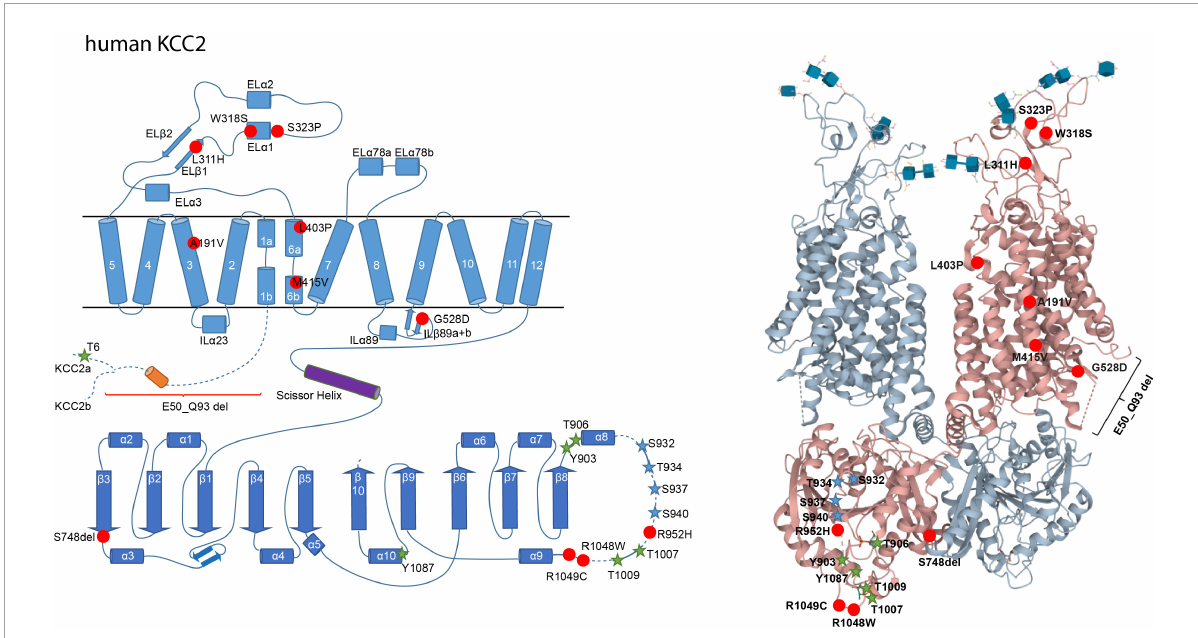
FIGURE2 Structural organization of human KCC2. 2-dimensional (left) and 3-dimensional (right) organization of human KCC2 according to Chi X. et al. (2020) (PDB: 6m23). KCC2 consists of 12 transmembrane domains (TMs) and two intracellular termini. A large extracellular loop is located between transmembrane domains 5 and 6 (EL3) and five N-glycosylation sites (blue cubes, left). Phosphorylation sites that increase KCC2 activity upon dephosphorylation are marked as green stars (Thr 6 in KCC2a, Thr 906 , Tyr 903 , Thr 1007 , Thr 1009 , and Tyr 1087 ). Phosphorylation sites that increase KCC2 activity upon phosphorylation are marked as blue stars (Ser 932 , Thr 934 , Ser 937 , Ser 940 ). Human pathogenic variants of KCC2 associated with epilepsy, autism-spectrum disorder, and schizophrenia are depicted as red dots (Ala 191 Val , Leu 311 His , Trp 318 Ser , Ser 323 Pro , Leu 403 Pro , Met 415 Val , Gly 528 Asp , Arg 952 His , Arg 1048 Trp , Arg 1049 C , Ser 748 del ). Annotation of amino acid residues is according to human KCC2b. The 3D reconstruction of KCC2 was generated using cryo-EM (Chi X. et al., 2020). 3D visualization was performed using Mol* Viewer in PDB (Sehnal et al.,